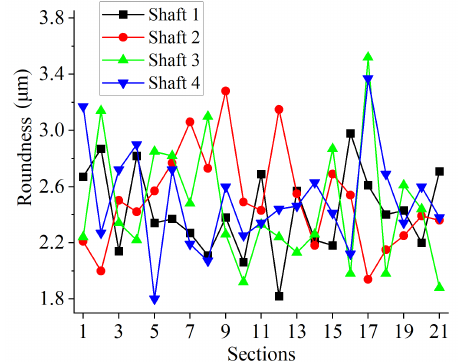
Figure 12. Roundness errors of four shafts.